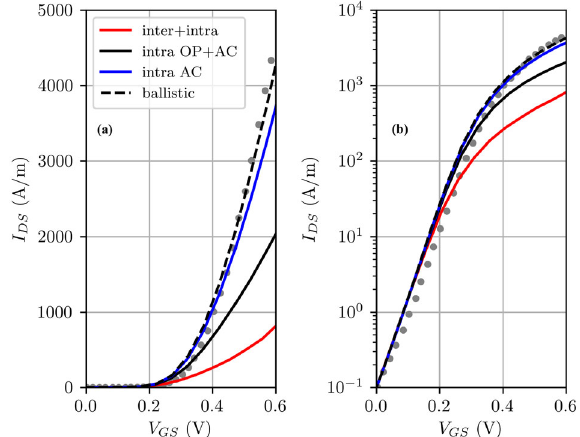
Fig. 2 Calculated transfer characteristic including different electron – phonon scattering for an Sb-based double-gate transis- tor with L G = 5 nm. I DS – V GS in a linear and b logarithmic scale. The considered electron – phonon scattering processes are: intravalley scattering mediated by acoustic phonons (blue line), intravalley scattering mediated by acoustic and optical phonons (black line), and both intervalley and intravalley scattering mediated by acoustic and optical phonons (red line). The results obtained in the ballistic transport regime (dashed lines) are compared to the values (gray dots) reported in ref. 13 .